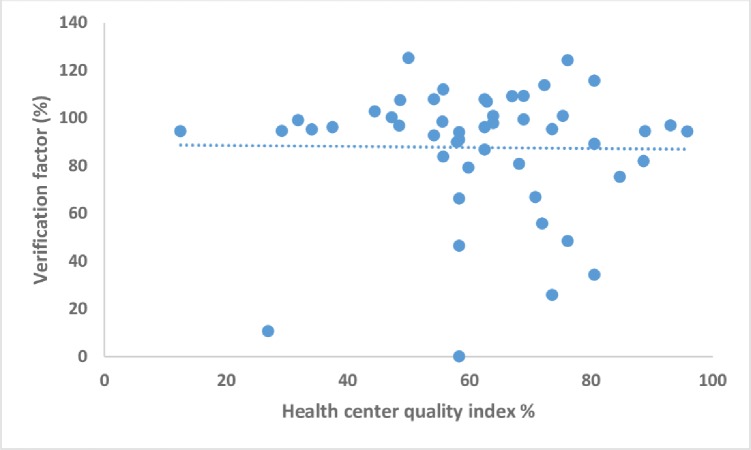
Correlation between verifaction factor and quality index score at health center level, in Kabalore District, from data quality audit 2015.